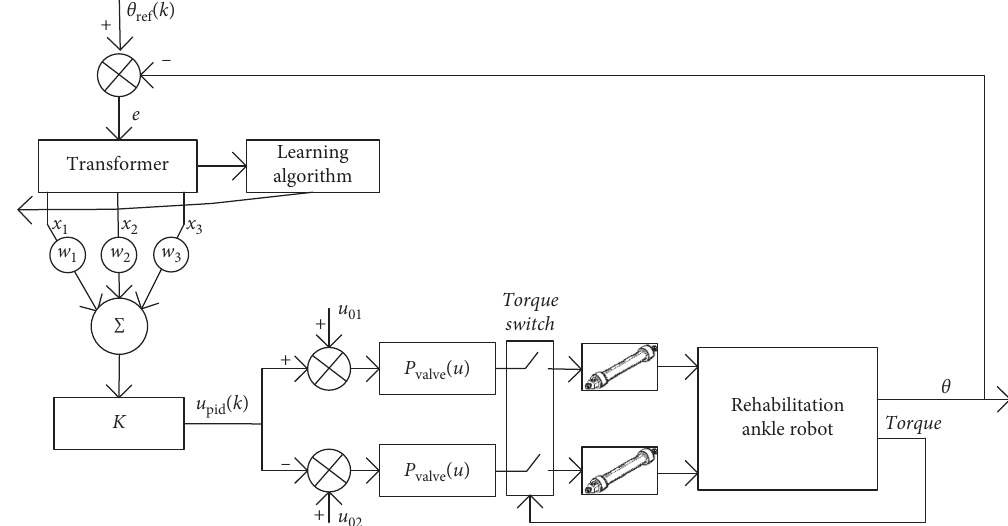
Figure 7: Tracking controller of the robot in passive rehabilitation therapy.